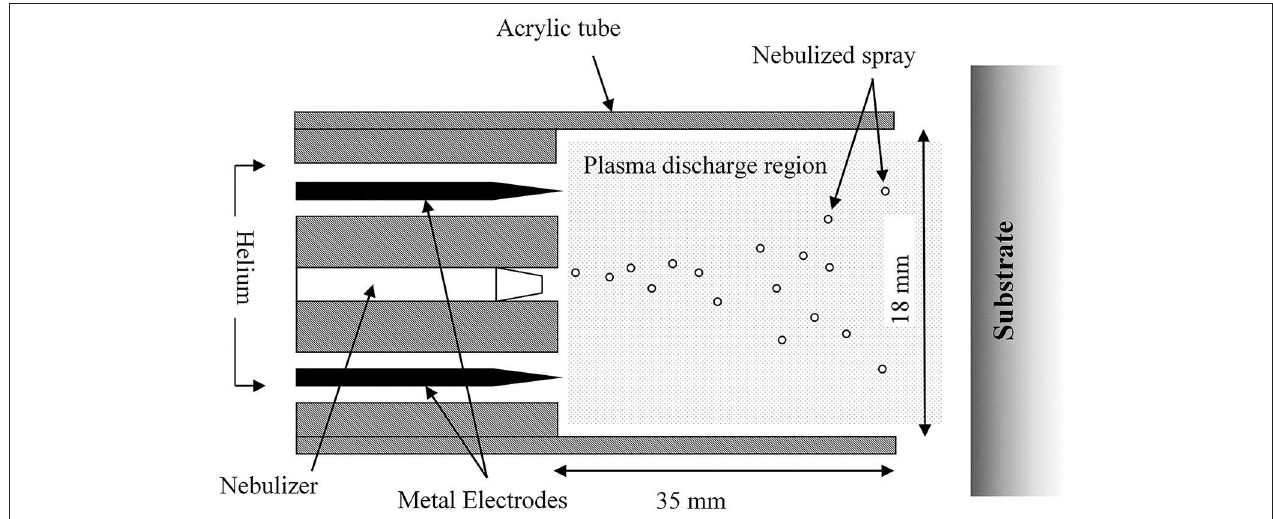
FIGURE 1 | Plasma deposition